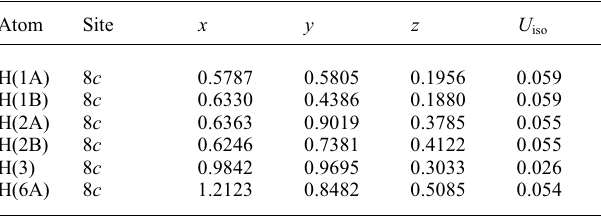
Table 2. Atomic coordinates and displacement parameters (in Å 2 )